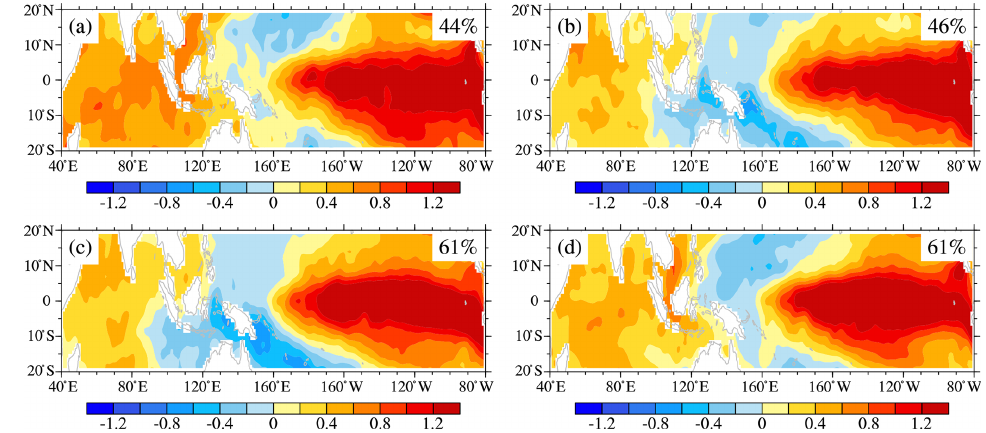
Figure 2. Spatial patterns of the first leading mode of the (a) spring (March, April and May), (b) summer (June, July and August), (c) autumn (September, October and November) and (d) winter (December, January and February) averaged SST anomalies over the Pacific–Indian Ocean (20 ◦ S–20 ◦ N, 40 ◦ E–80 ◦ W) calculated from the HadISST dataset (unit: ◦ C). The numbers in the upper right corner of each panel indicate the percentage of variance explained by each